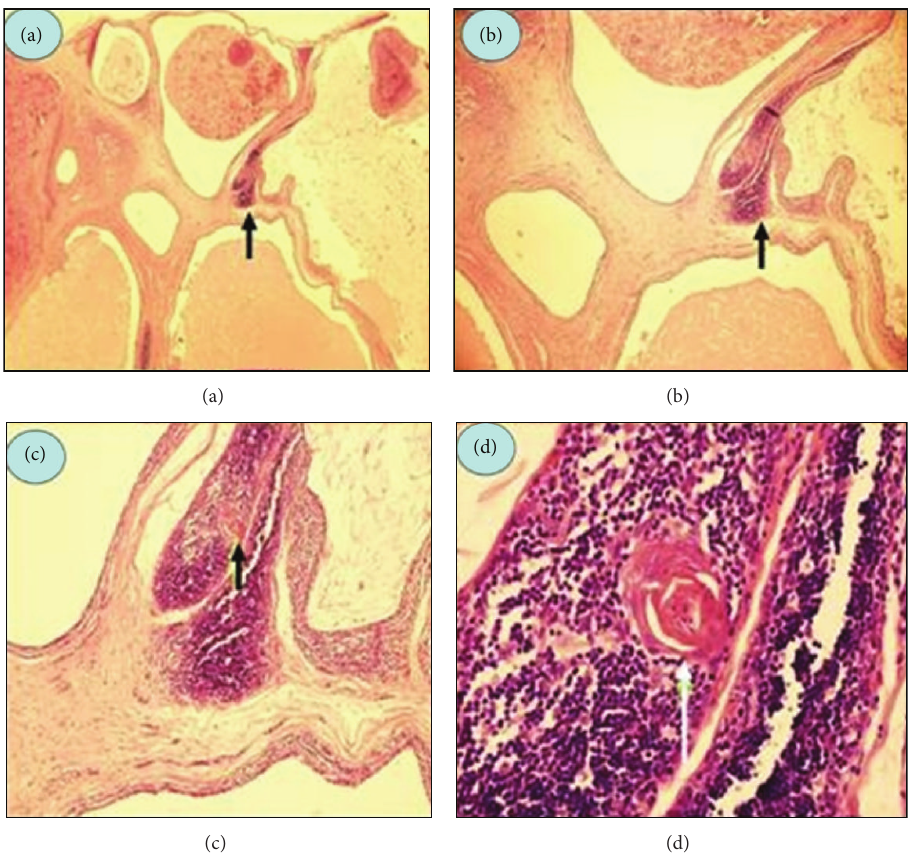
Figure 5: (a) Multilocular cyst and lymphoid tissue (arrow) (Hematoxylin-eosin stain, original magnification, × 20); (b) Lymphoid tissue (arrow) in the cyst wall (Hematoxylin-eosin stain, original magnification, × 40); (c) Hassall’s corpuscle within the lymphoid tissue (Hematoxylin-eosin stain, original magnification, × 100), (d) Hassall’s corpuscle (Hematoxylin-eosin stain, original magnification, ×